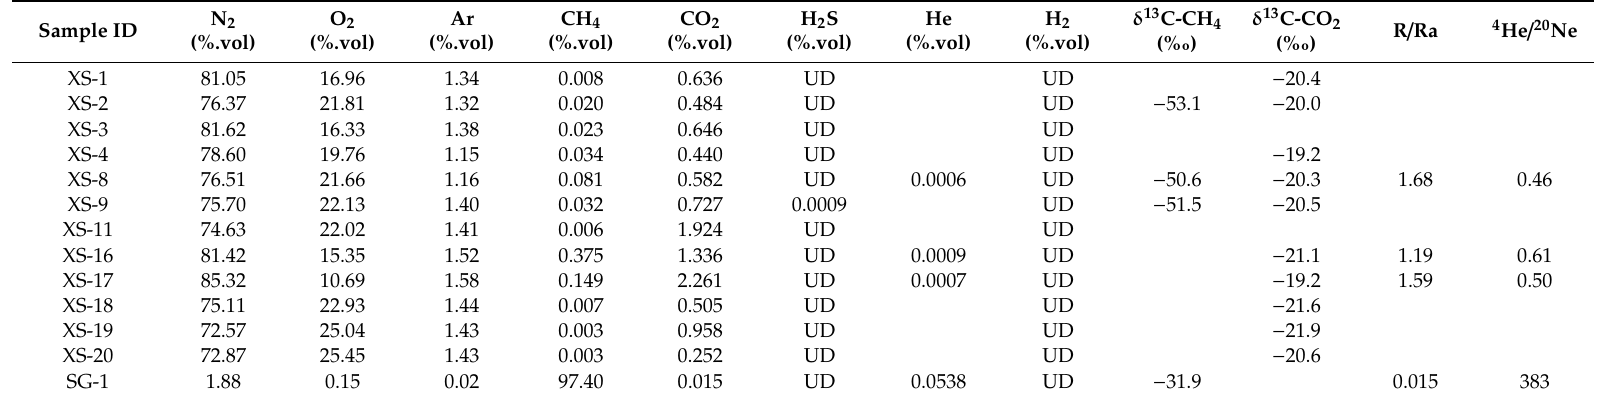
Table 2. Volume fraction, isotopic composition of dissolved gas samples of shallow groundwater and a shale gas sample